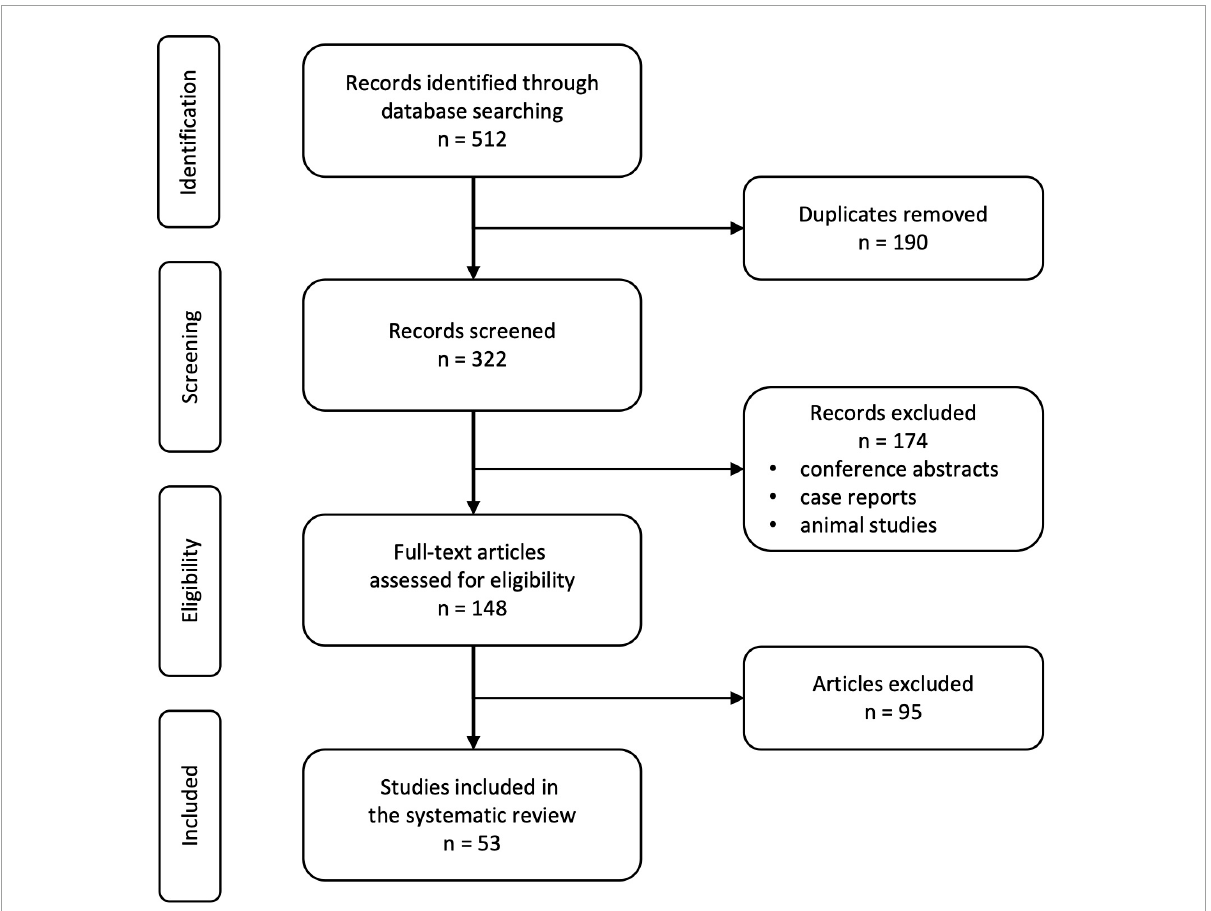
FIGURE3 PRISMA flow chart of the selection